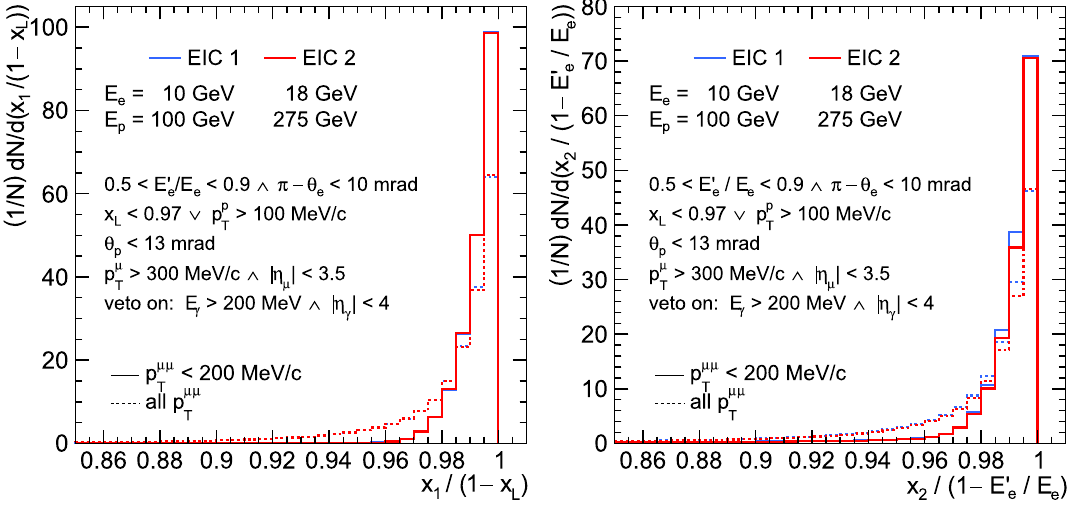
for two energy configurations of the T